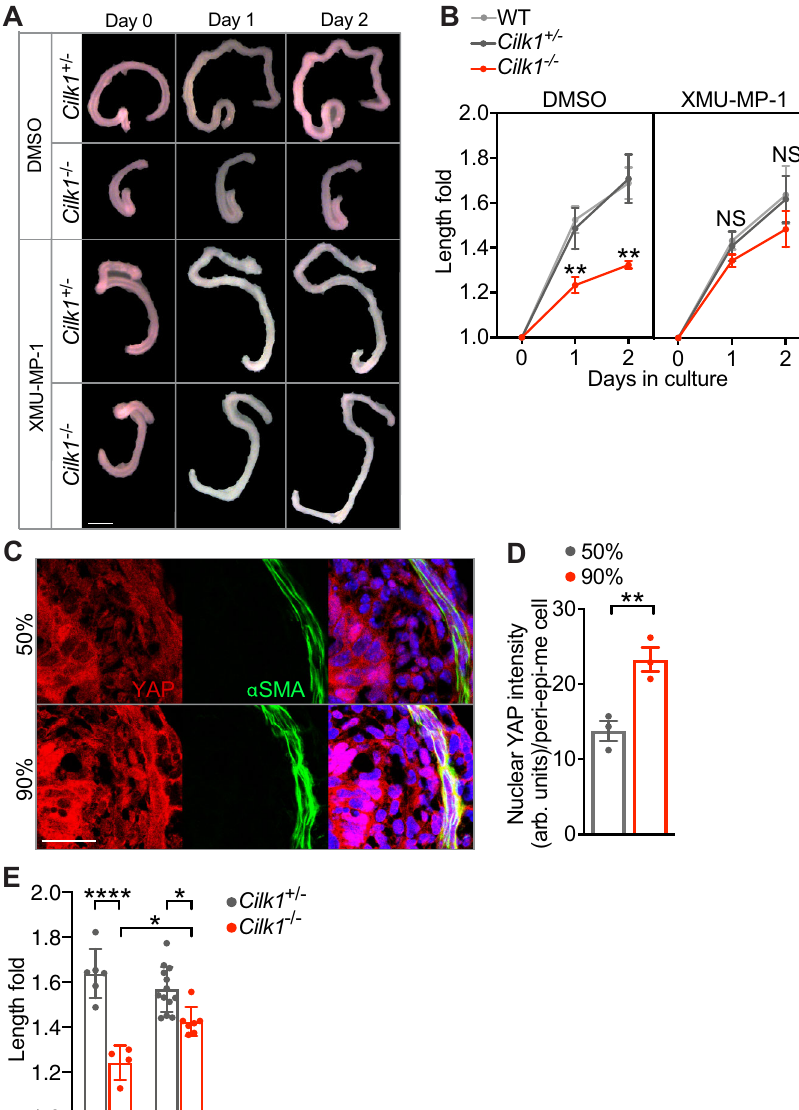
Fig. 6 Modulating the Hippo pathway restores elongation of Cilk1 − / − intestine. A Representative E13.5 intestines of indicated genotypes before (Day 0) and after culture in Matrigel with DMSO or XMU-MP-1 for indicated days. Scale bar, 1 mm. B Fold change of intestinal length after culture in Matrigel with DMSO (WT, n = 6; Cilk1 + / − , n = 5; Cilk1 − / − , n = 4) or XMU-MP-1 (WT, n = 3; Cilk1 + / − , n = 4; Cilk1 − / − , n = 6) for indicated days. The values are presented as means ± SD. ns p > 0.05, ** p < 0.01 by two-way ANOVA Sidak ’ s multiple comparisons test (adjusted P values are 0.0046 for day 1 and 0.0025 for day 2 between Cilk1 + / − DMSO and Cilk1 -/- DMSO). C Immuno fl uorescence staining of E13.5 wild-type intestine cultured for one day in 50% or 90% Matrigel for YAP (red), smooth muscle ( α SMA, green) and nuclei (Hoechst, blue). Scale bars, 25 μ m. D Nuclear YAP intensities of peri-epithelial mesenchymal cells in C . n = 3 for each group. For each intestine, the nuclear YAP intensity per cell was averaged from three sections. Values are presented as means ± SEM. ** p = 0.035 by two-sided paired t test. E Fold change of intestinal length after culture in 50% ( Cilk1 + / − , n = 6; Cilk1 -/- , n = 4 or 90% ( Cilk1 + / − , n = 13; Cilk1 -/- , n = 7) Matrigel for two days. The values are presented as means± SD. * p < 0.05, **** p < 0.0001 by one-way ANOVA Turkey ’ s multiple comparisons test. Adjusted P value are: 0.0194 for Cilk1 -/- 50% vs Cilk1 -/- 90% and 0.0145 for Cilk1 + / − 90% vs Cilk1 -/- 90%. Source data are provided in the Source Data fi